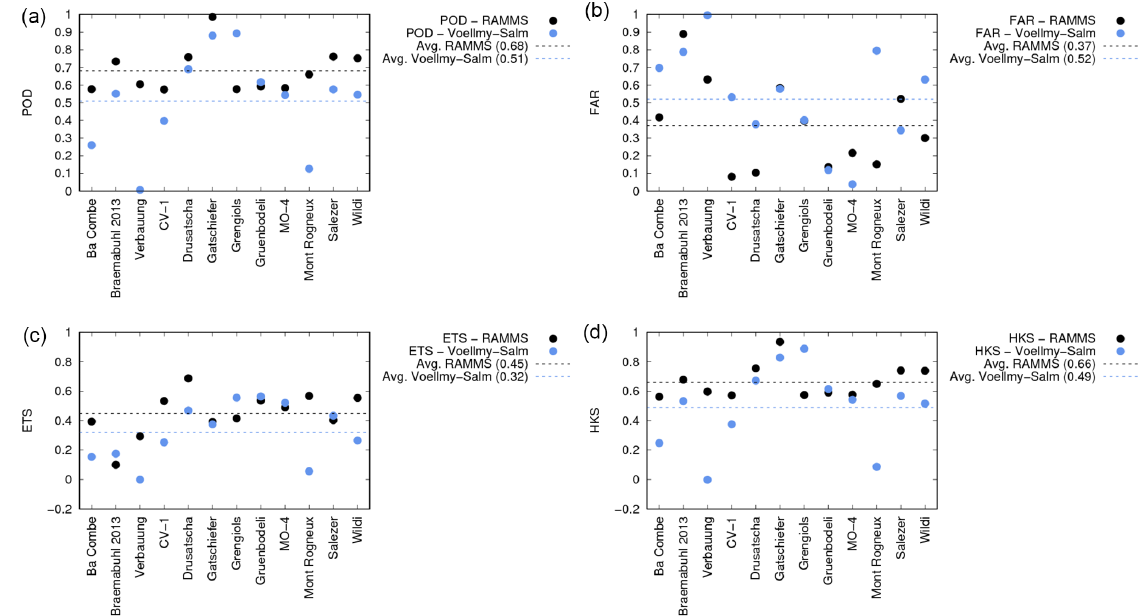
Figure 4. Comparison of the statistical results from the thermomechanical model RAMMS (black) and the guideline-VS model (blue), for POD (a) , FAR (b) , ETS (c) and HKS (d) .